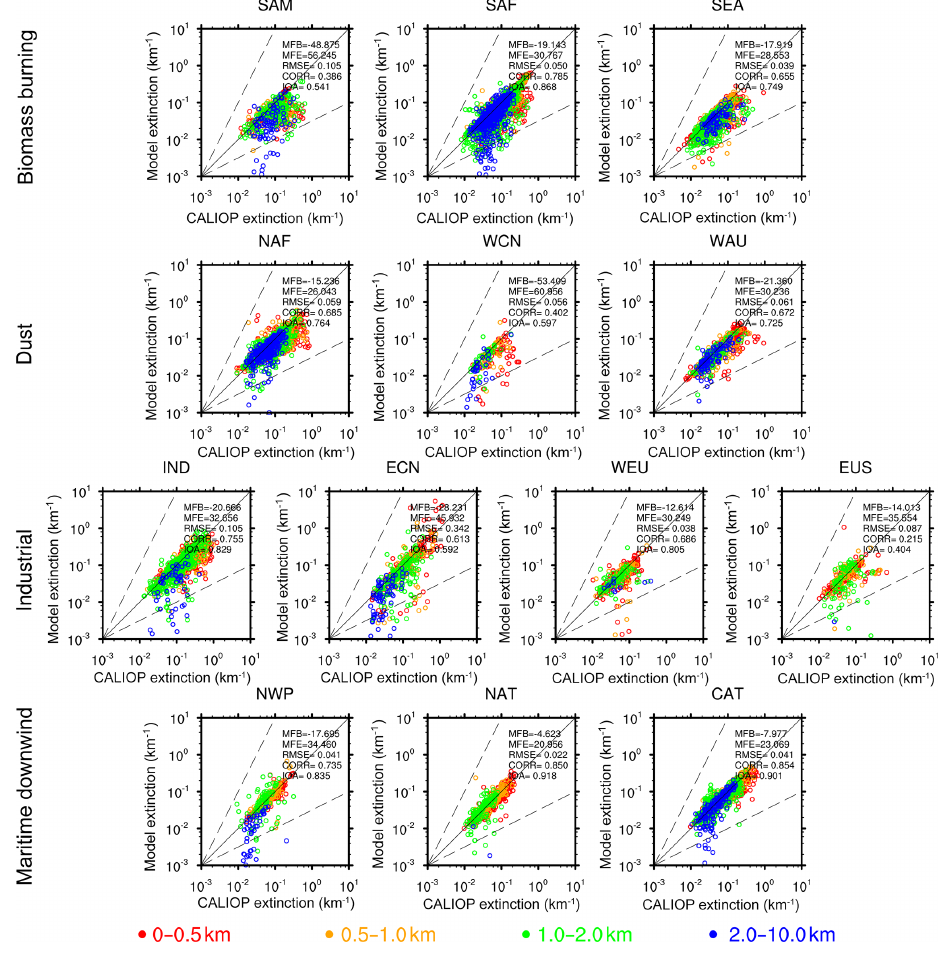
Figure 5. Same as Fig. 4 but for the LETKF-CALIPSO